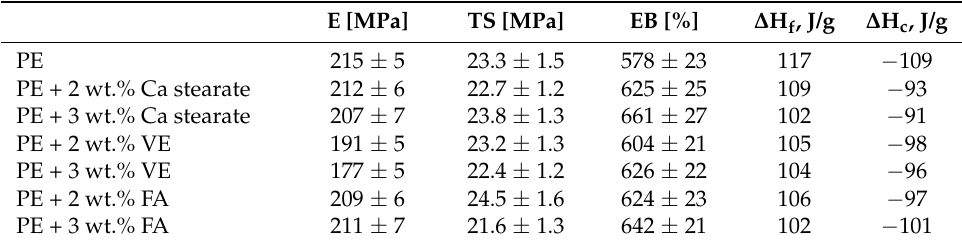
Table 1. Main mechanical properties, i.e., elastic modulus, E, tensile strength, TS, and elongation at break, EB, and fusion ( ∆ Hf) and crystallization ( ∆ Hc) enthalpies for neat PE and PE containing different compounds before UVB exposure. E [MPa] TS [MPa] EB [%] ∆ H f , J/g ∆ H c , J/g PE 215 ± 5 23.3 ± 1.5 578 ± 23 117 − 109 PE + 2 wt.% Ca stearate 212 ± 6 22.7 ± 1.2 625 ± 25 109 − 93 PE + 3 wt.% Ca stearate 207 ± 7 23.8 ± 1.3 661 ± 27 102 − 91 PE + 2 wt.% VE 191 ± 5 23.2 ± 1.3 604 ± 21 105 − 98 PE + 3 wt.% VE 177 ± 5 22.4 ± 1.2 209 ± 6 24.5 ± 1.6 PE + 3 wt.% FA 21.6 ±